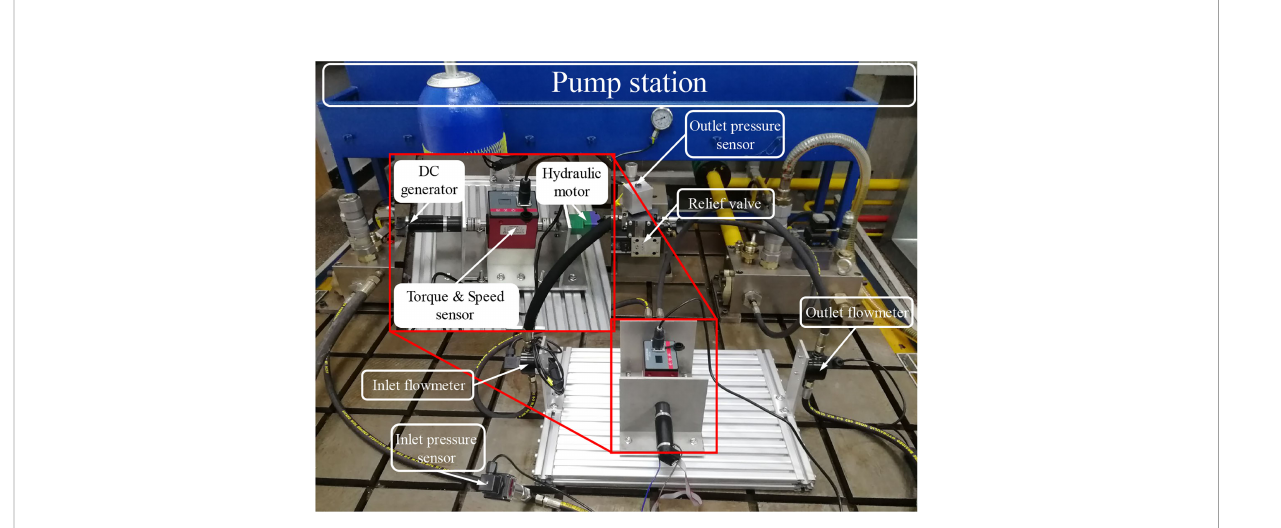
FIGURE 2 The experimental platform of the energy conversion